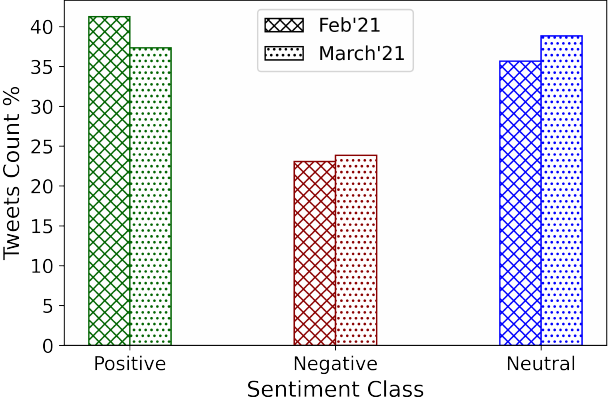
Figure 6. Change in the overall sentiment scores from early February to late March